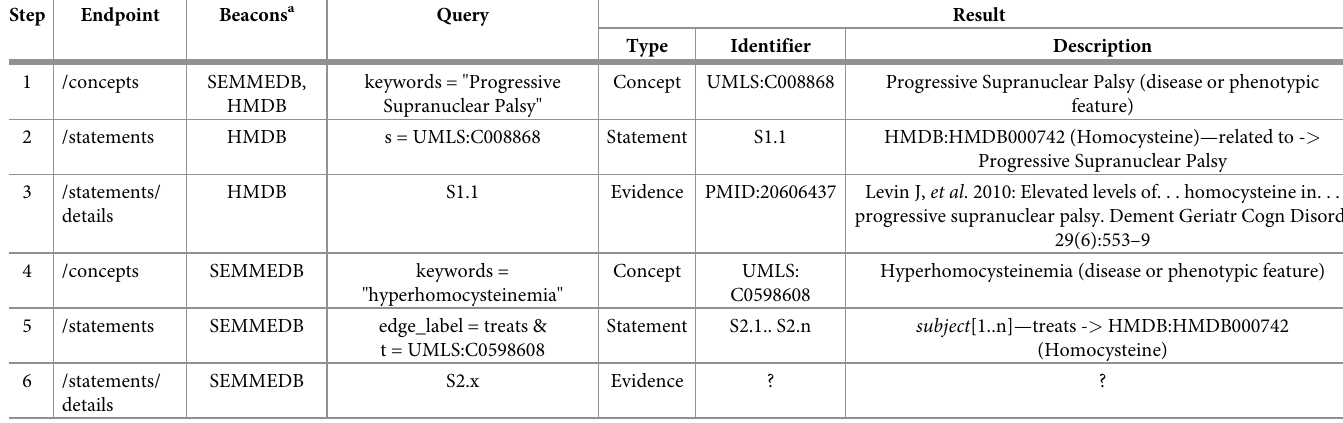
Table 2. Example of a basic sequence of beacon queries to discover knowledge about a human